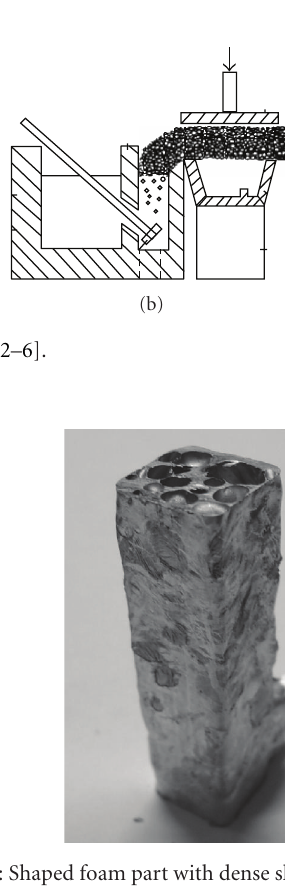
Figure 3: Shaped foam part with dense skin (19 × 19 ×